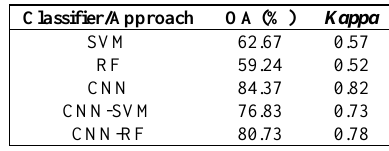
Table 3. Tree species classification results.